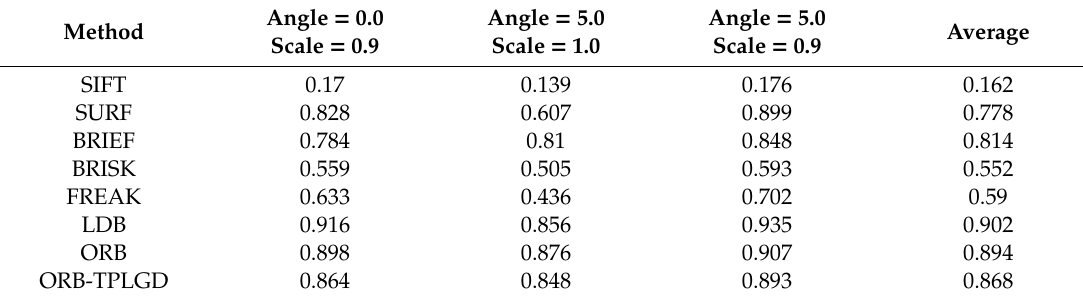
Table 9. Average matching RMSE of test image matching algorithms for SAR dataset (pixel).